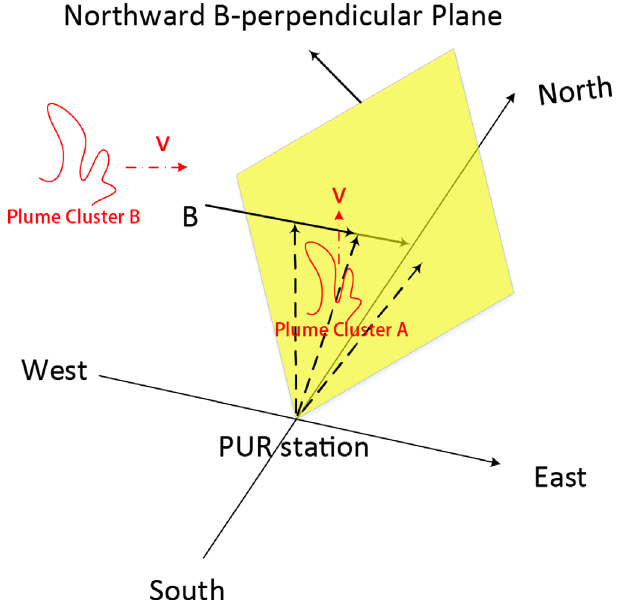
Fig. 8. Cartoon depictions for the evolutions of the ionosonde backscatter plumes. The yellow pane indicates the north direction ( B - perpendicular direction) of radio waves at PUR station. The red curves represent ionospheric irregularities marked by plume cluster A and plume cluster B. The dot-black lines in the yellow pane represent the northwest, north, and northeast directions of radio waves transmitted from PUR